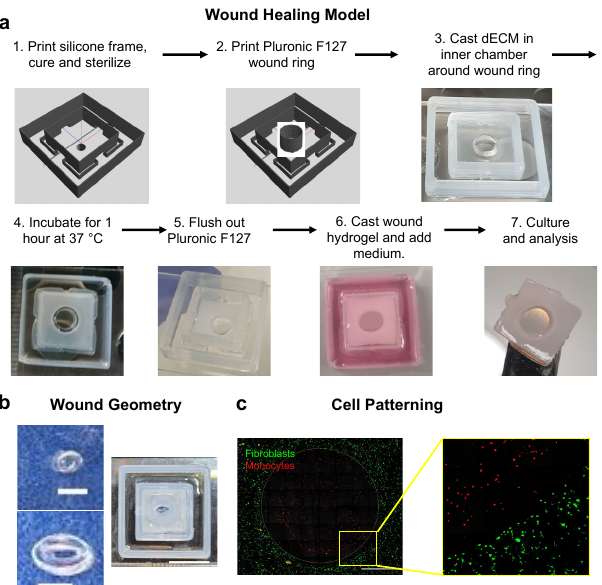
Figure 5. Application dECM in 3D printed wound healing model. ( a ) Schematic of fabrication of 3D printed wound healing model consisting of 3D printed silicone (SE1700) inner (12 mm × 12 mm) and outer (24 mm × 24 mm) frames with 2 mm wide x 4 mm tall gaps in the inner frame. A model wound is created by 3D printing a sacrificial Pluronic F127 ring (3 mm diameter), casting dECM hydrogels around the ring, and removing the ring with cold medium. A fibrin gel can then be cast in the wound and cultured in cell culture medium. ( b ) Example of different wound geometries consisting of ellipses (1.0 mm × 0.5 mm upper or 2.5 mm × 2.0 mm lower and right). Scale bars equal 1 mm left and 10 mm right. ( c ) Fluorescence images of monocytes and fibroblasts labeled with Cellbrite membrane dyes in the fibrin wound or dECM tissue compartments, respectively. Scale bar equals 1 mm.